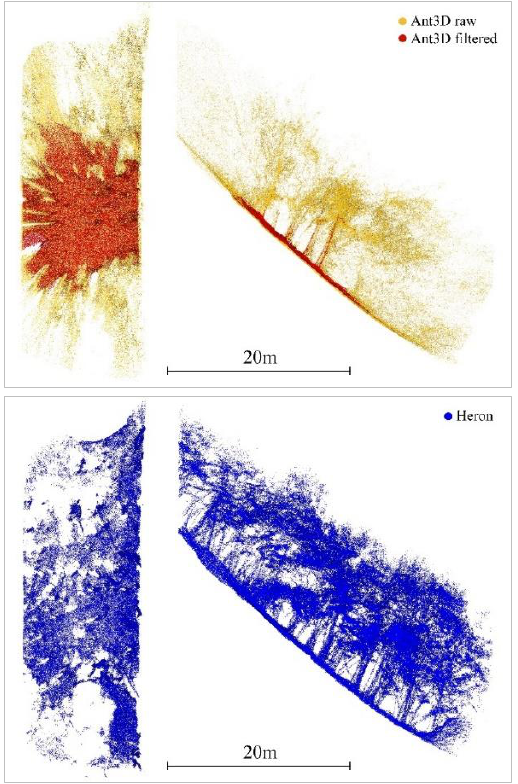
Figure 8. Data completeness of the PCs in a portion of the undergrowth path.